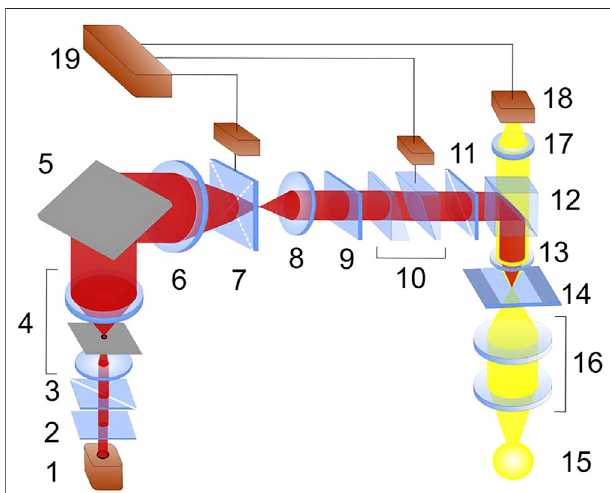
FIGURE 3 | Optical arrangement of tweezers based on a birefringent crystal: (1) laser; (2) quarter-wave plate; (3, 11) polarizers; (4) beam expander with spatial fi ltering; (5) mirror; (6, 8, 13, and 17) micro-objectives; (7) biaxial crystal with a 3D rotating drive; (9) calcite plate; (10) calcite wedges with 2D shifting of one wedge; (12) beam-splitting dichroic cube; (14) sample; (15) white-light source for illumination; (16) condenser lenses; (18) CCD camera; (19)